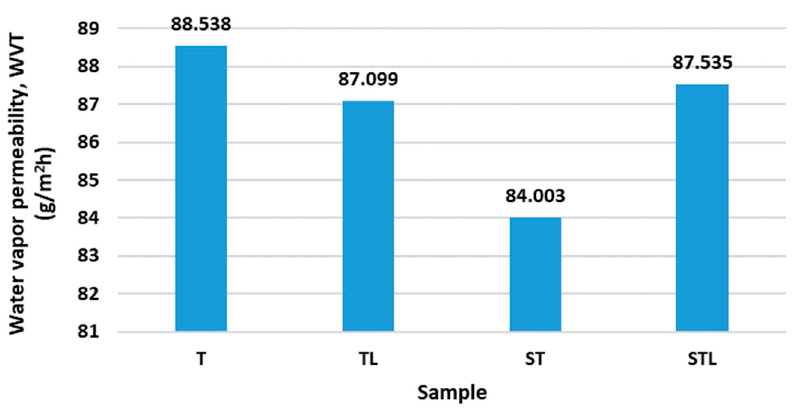
Figure 4. The results of water vapor permeability.